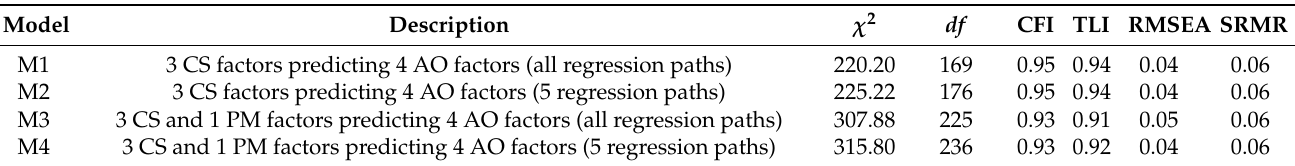
Table 2. Goodness of Fit of SEM models. Character Strength factors (CS) and Phronesis Motivation (PM) predicting Academic Outcomes